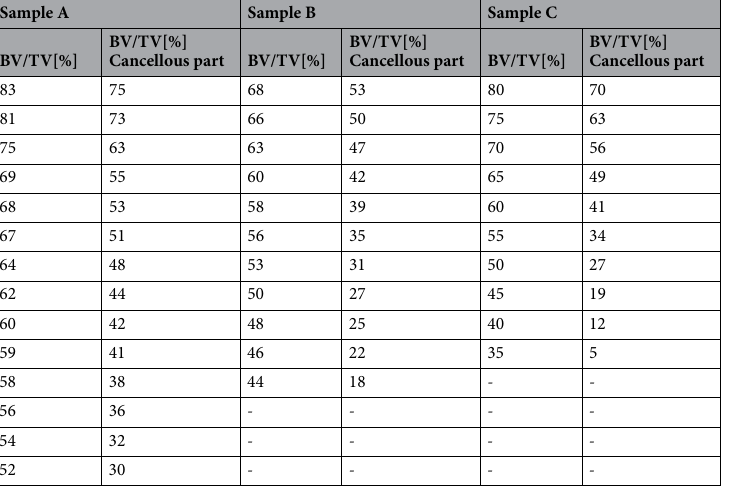
Table 1. BV/TV values of bone